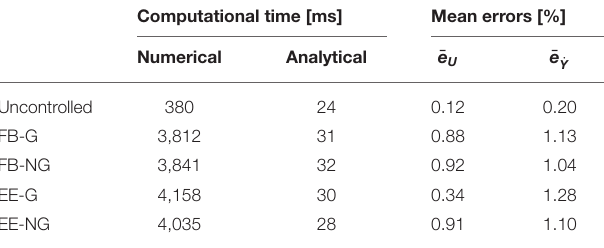
TABLE 2 | Computational times and mean errors for application of numerical and analytical